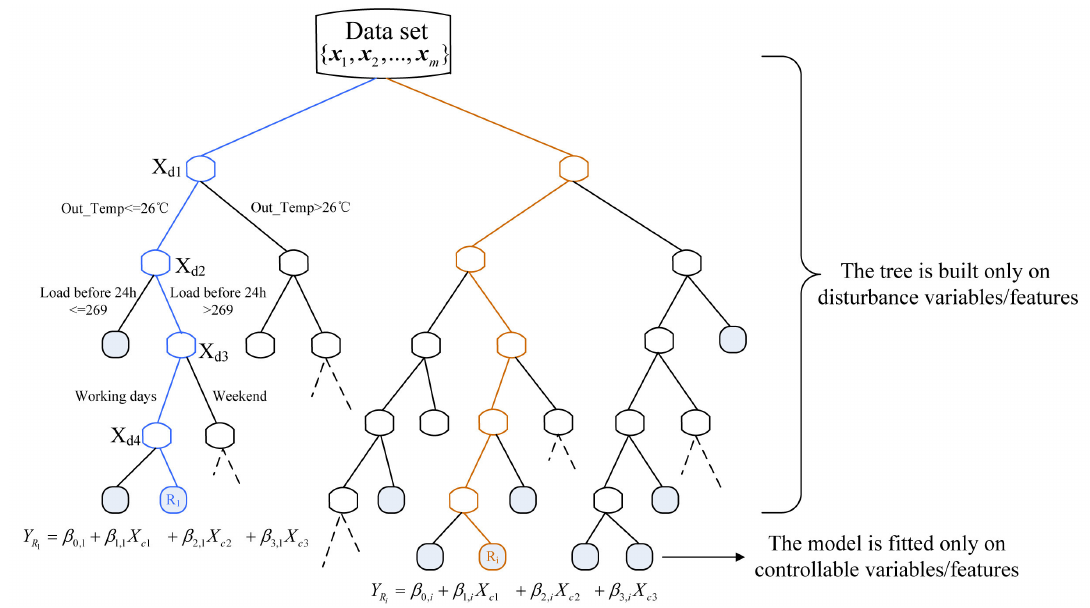
Figure 3. Example of a tree model built using the separated